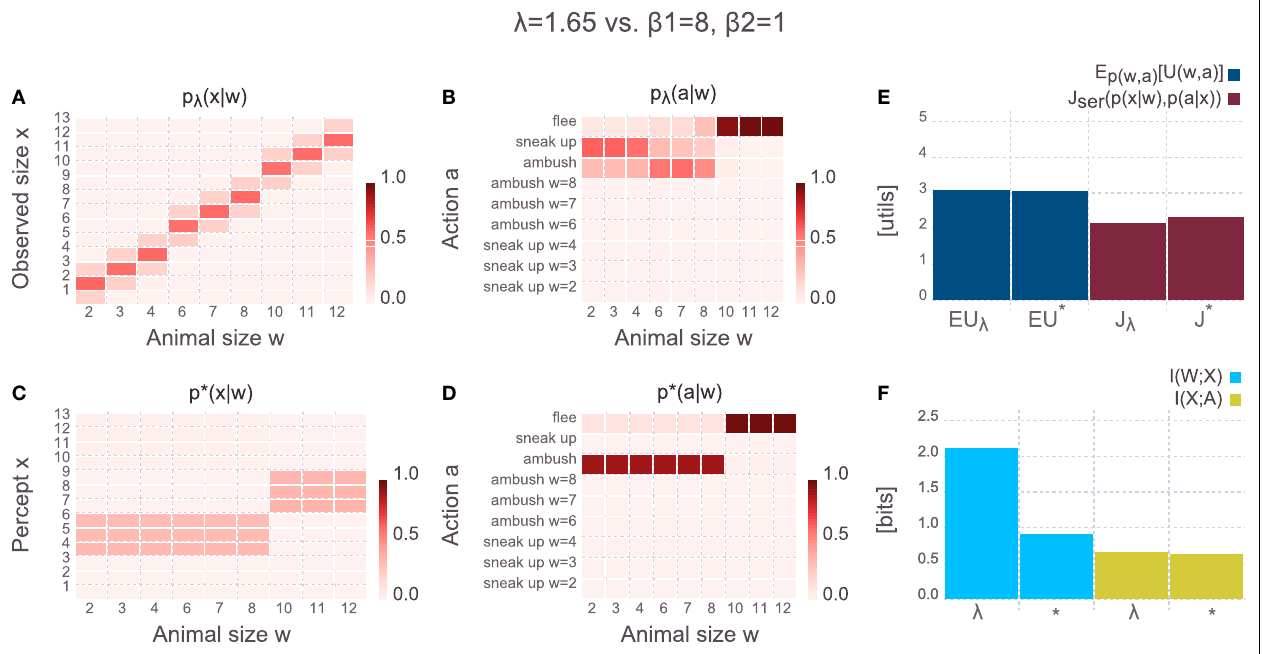
FIGURE 7 | Comparing hand-crafted perception against bounded-optimal perception (parameters are given above the panels) . Compared to Figure 6 , the action channel of both the hand-crafted and the bounded-optimal system now has low computational resources (through the low (cid:12) 2 for the action channel). (A) Hand-crafted perceptual model p (cid:21) ( x | w ) [equation (20)] – the hand-crafted perception is unaffected by the increased limit in computational resources on the action channel. (B) Overall-behavior of the system p (cid:21) ( a | w ) [equation (21)] with the hand-crafted perception. Even though perception was unaffected by the increased limit on the action channel, the overall-behavior is severely affected. (C) Bounded-optimal perceptual model p *( x | w ) [equation (15)] – due to the low information processing rate on the action channel [see (F) , yellow bars], the bounded-optimal perception adjusts accordingly and only discriminates between predator and prey animals. (D) Overall-behavior p *( a | w ) [equation (21)] of the bounded-optimal system. Compared to the hand-crafted system, the bounded-optimal system distinguishes sharply between predator and prey animals. Note, however, that both systems achieve an identical expected utility [ (E) , dark blue bars]. (E) Comparison of expected utility (dark blue, first two columns) and value of the objective [equation (14), dark red, last two columns] for the hand-crafted system (denoted by (cid:21) ) and the bounded-optimal system (denoted by *). Both systems achieve the same expected utility, but the bounded-optimal system does so with requiring less